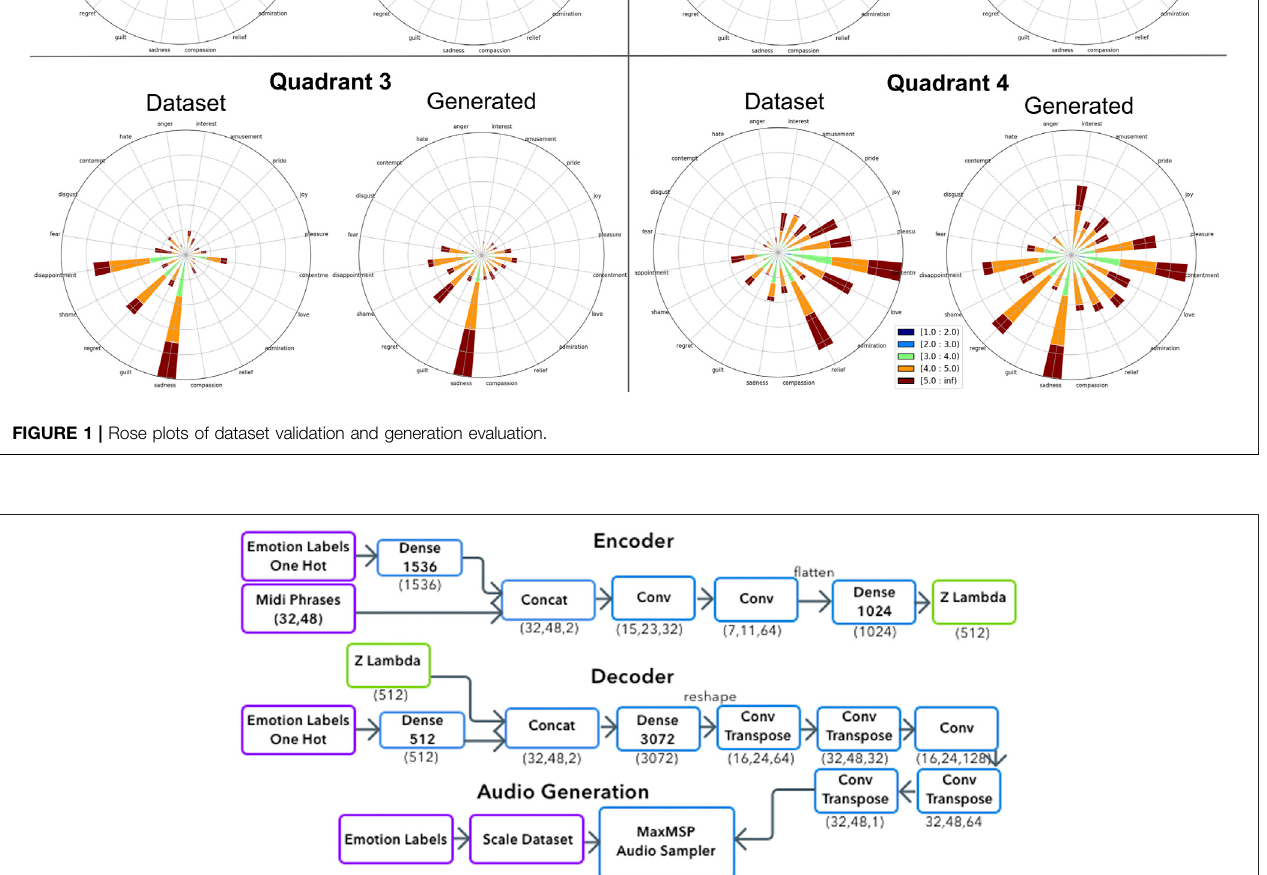
FIGURE 2 | Generative System